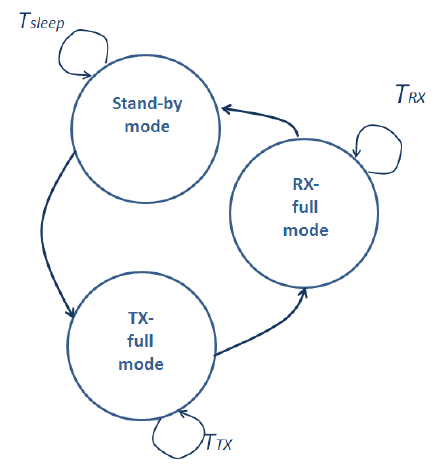
Figure 7. Sensor node state basic